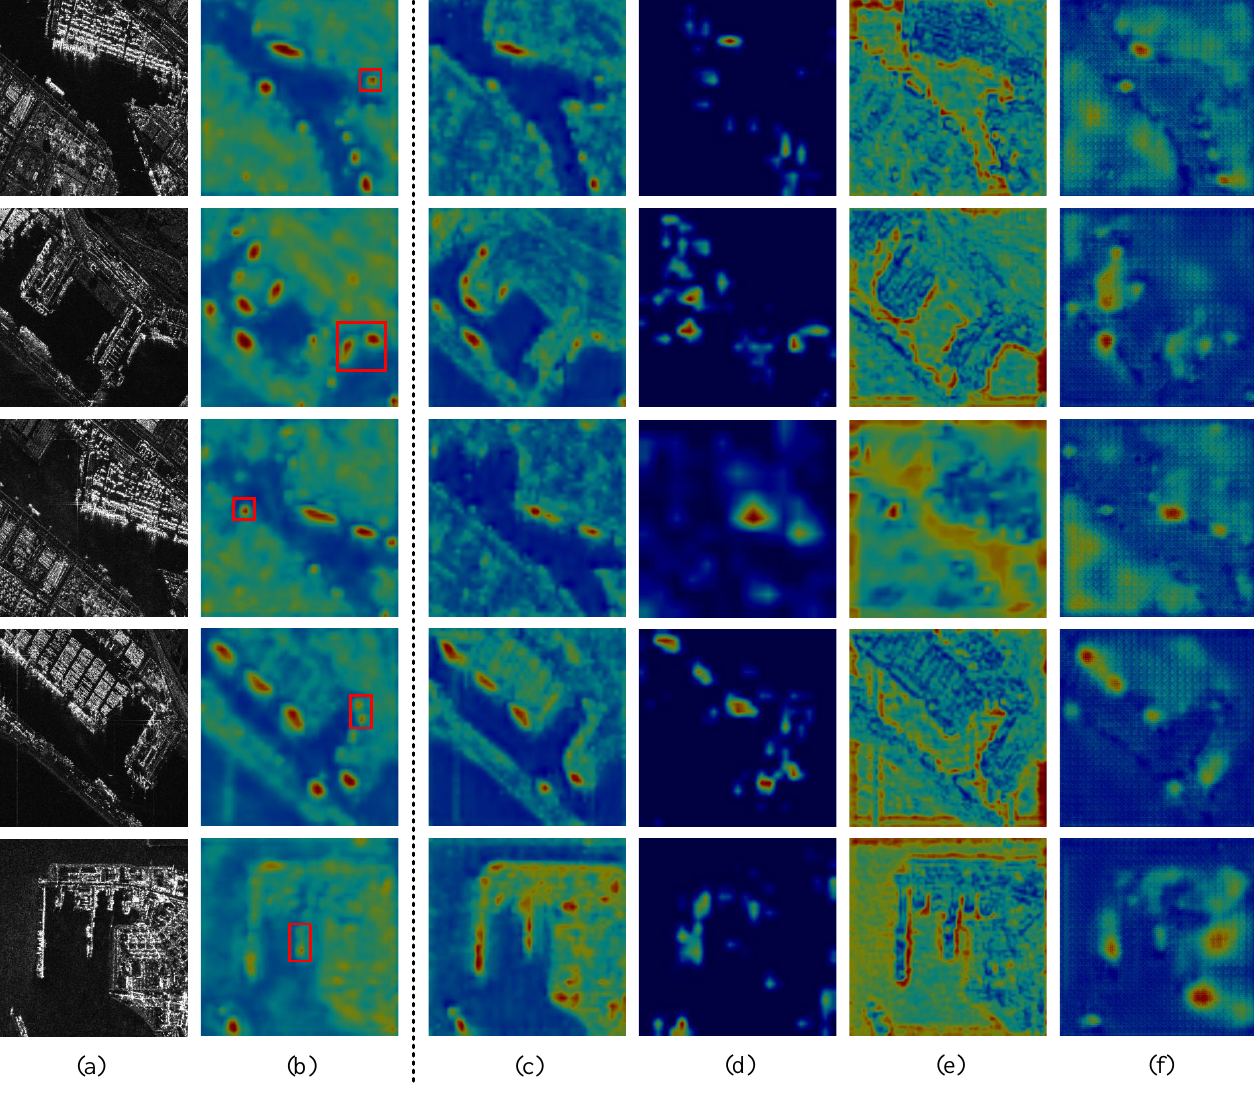
Figure 8. Feature map visualization results of our method and compared methods. ( a ) Input image. ( b ) Our method. ( c ) Baseline. ( d ) RetinaNet. ( e ) DETR. ( f ) CenterNet. The red box in ( b ) shows the outstanding performance of our method compared to other